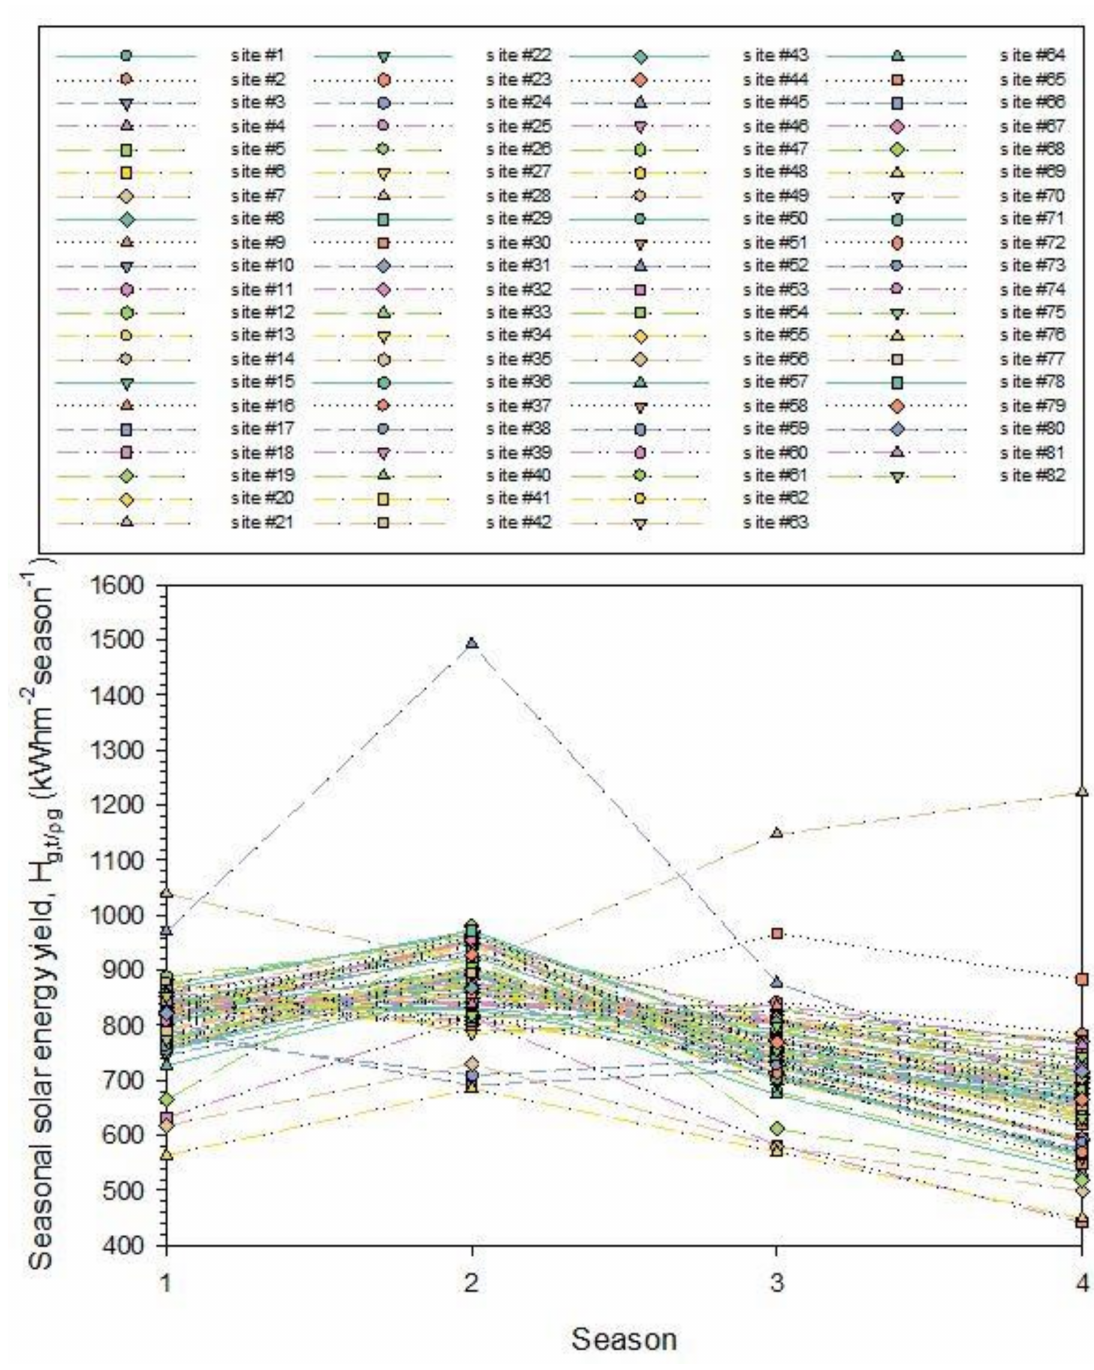
Figure 7. Seasonal variation of H g,t/ ρ g under all-sky conditions for all 82 sites. The seasonal values are sums of the hourly solar radiation ones for each site and averaged over each season in the period 2005–2016. The numbers in the legend correspond to the sites shown in column 1, Table 1. The numbers 1–4 in the x -axis refer to the seasons in the sequence spring to